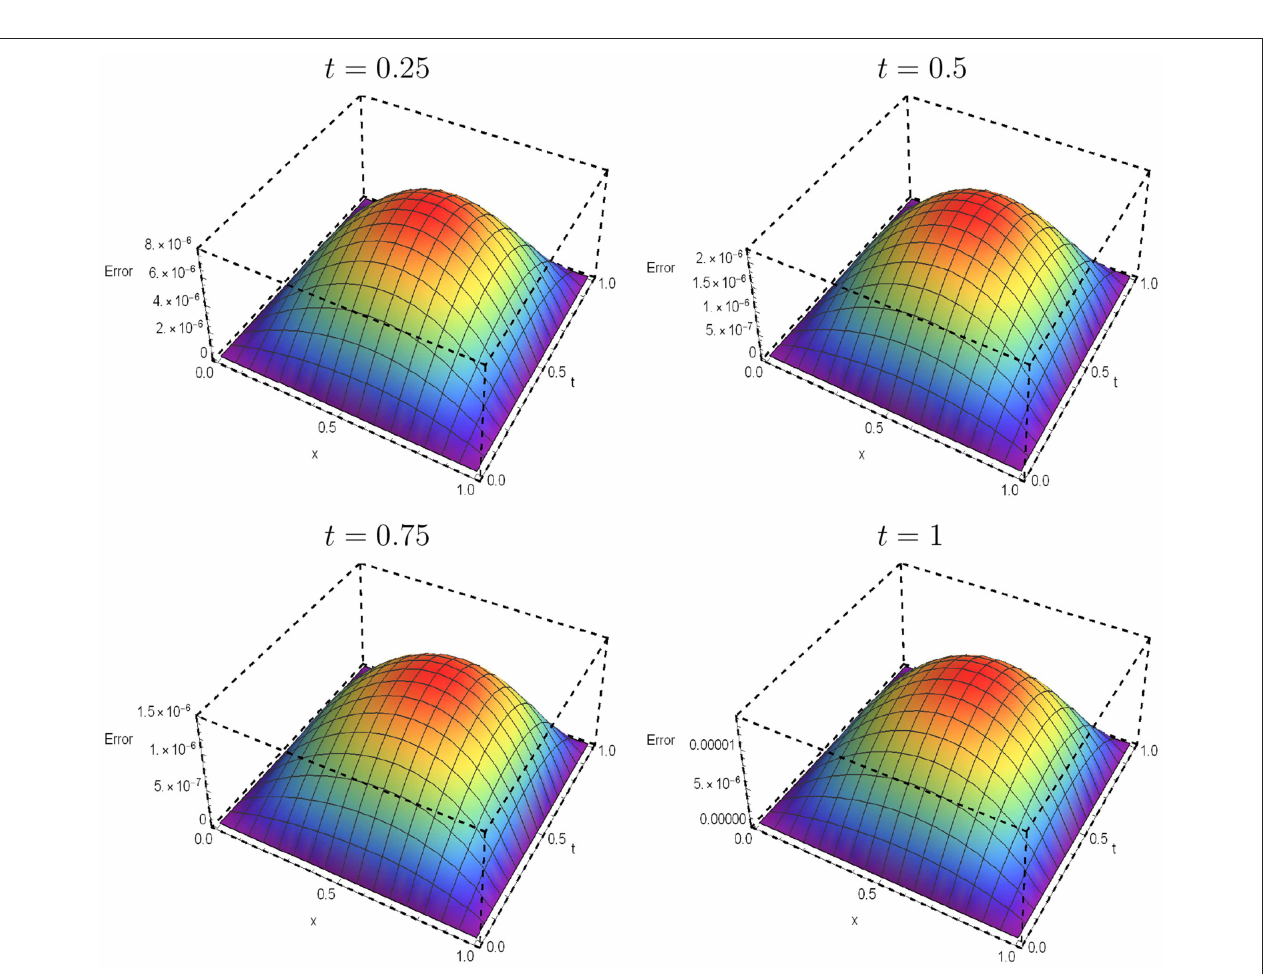
FIGURE 1 | The space-time graphs of the absolute error functions for Example 5.2 at various choices of t with γ = − η = 1 / 2, N = M = K = 8 and ω ( ν ) = Ŵ (1 + α + ν ), α = 0.5.